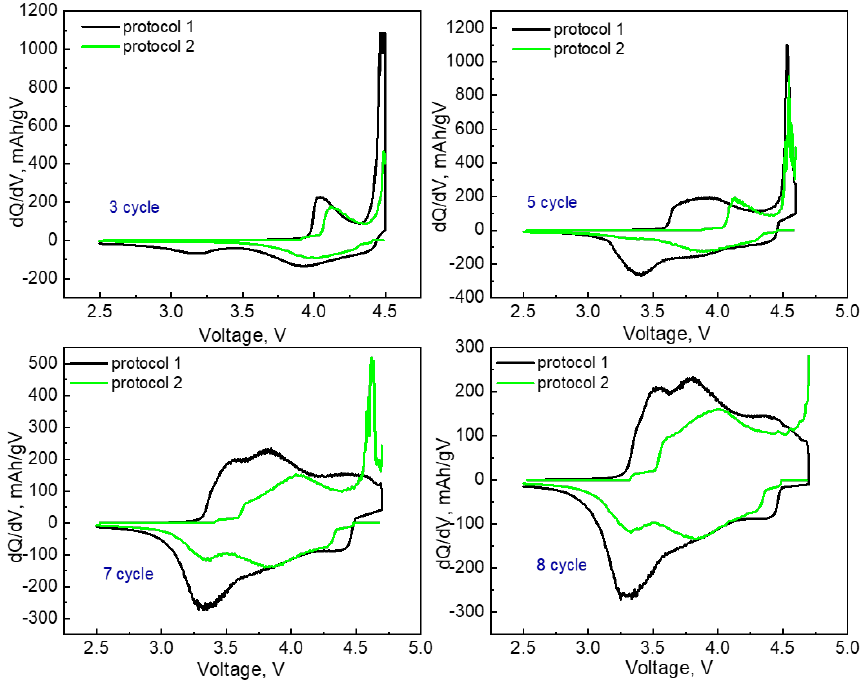
Figure 4. dQ/dV curves of LMR50 sample with different formation protocols.